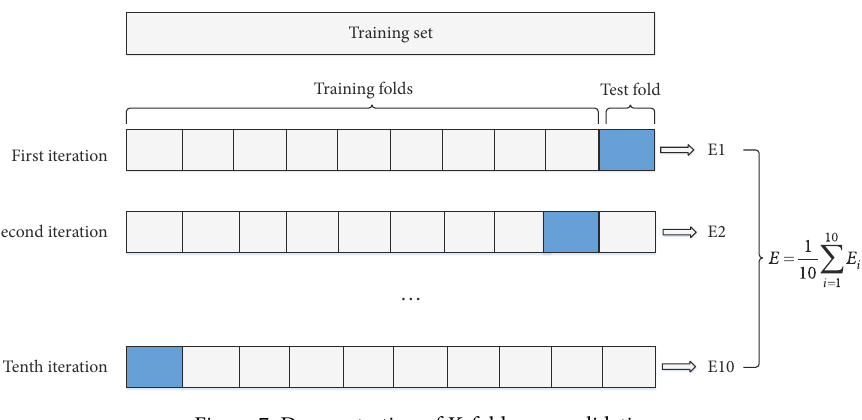
Figure 7. Demonstration of K-fold cross-validation